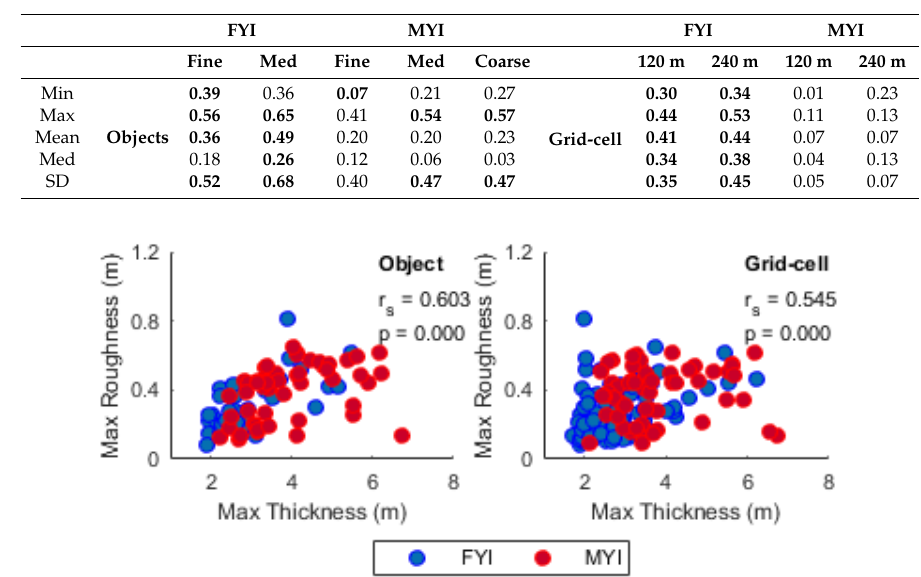
Table 5. Spearman correlation coefficients (r s ) between metrics of winter sea ice roughness and thickness for FYI and MYI at fine, medium (med) and coarse spatial scales (object) as well as 120 and 240 m grid-cells. Bolded values are statistically significant ( p < 0.05).